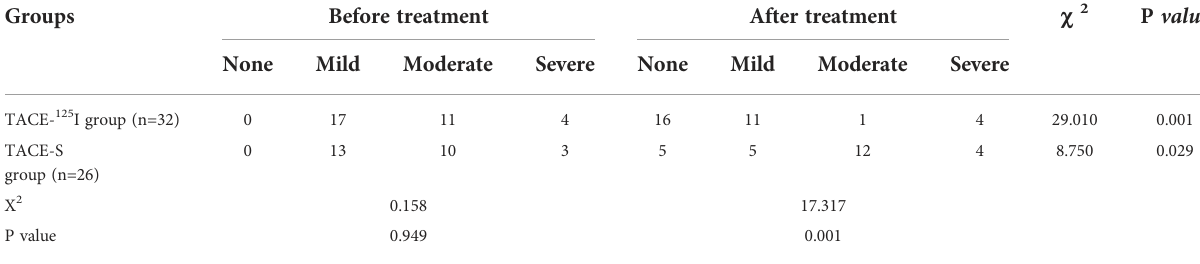
TABLE 2 Comparison of APFs grades before and 3 months after treatment between the TACE- 125 I group and the TACE-S group. Groups Before treatment After treatment